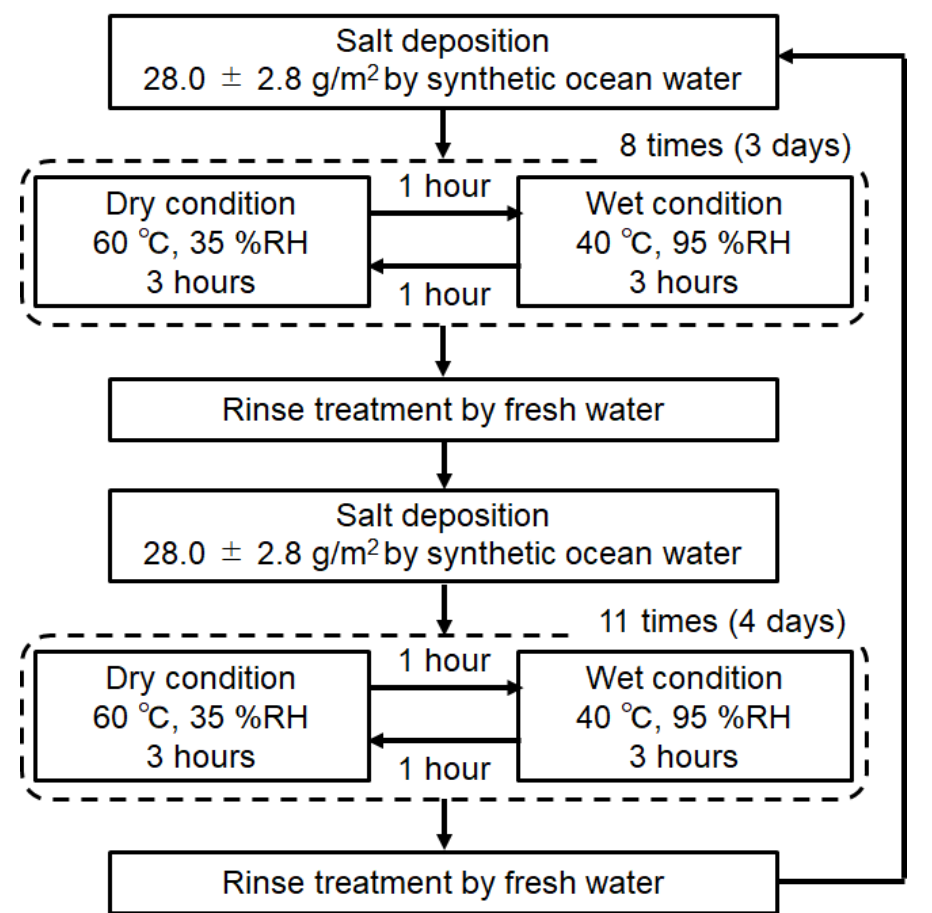
Figure 2. The procedure of seawater spray experiment ISO16539.